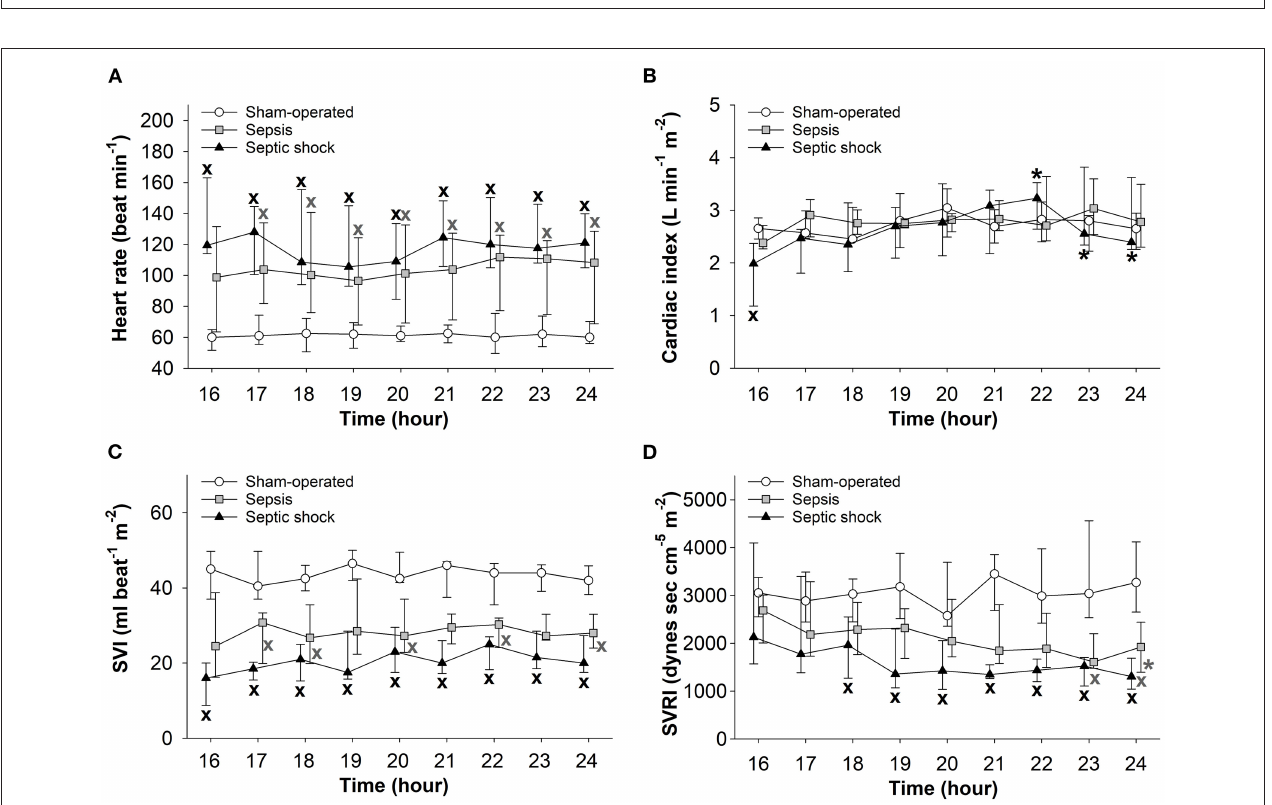
FIGURE 5 | Changes in heart rate (A) , cardiac index (B) , stroke volume index (SVI) (C) , and systemic vascular resistance index (SVRI) (D) in the sham-operated group (open circles) and the sepsis (gray square) and septic shock subgroups (black triangle). The plots demonstrate the median values and the 25th (lower whisker) and 75th (upper whisker) percentiles. X P < 0.05 vs. sham-operated group; * P < 0.05 vs. t = 16h.